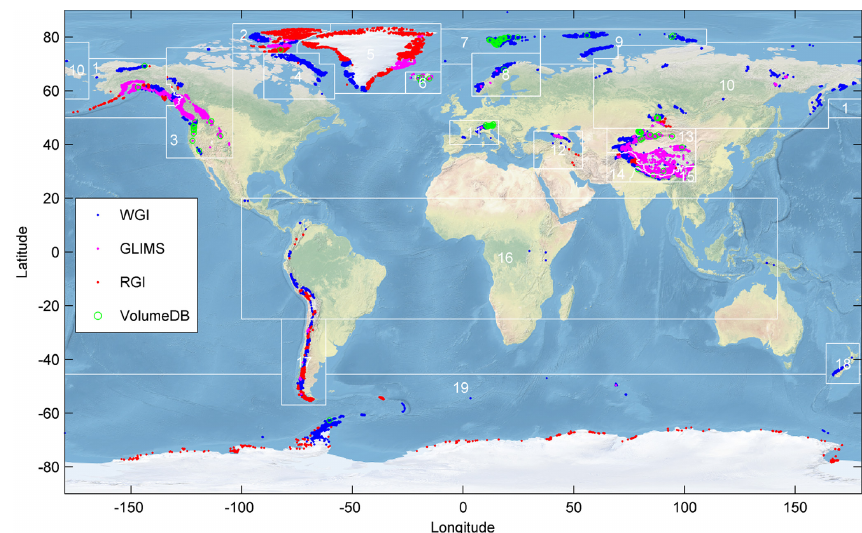
Fig. 1. Spatial distribution of glaciers in the four glacier inventories used in this study. GLIMS glaciers that are already in WGI are not plotted and neither are RGI glaciers overlapping with WGI and GLIMS. VolumeDB refers to the updated Cogley (2012) area volume database used for calibration. White boxes show the regions as defined by Arendt et al. (2012) and region numbers are listed in Tables 2 and